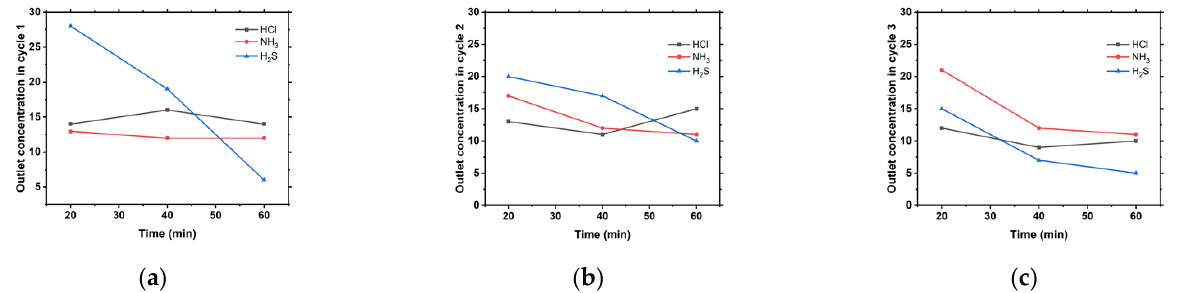
Figure 4. The outlet concentrations of contaminants in the calcination stage at carbonation temperature of 650 °C for the first ( a ), the second ( b ), and the third cycle ( c ).